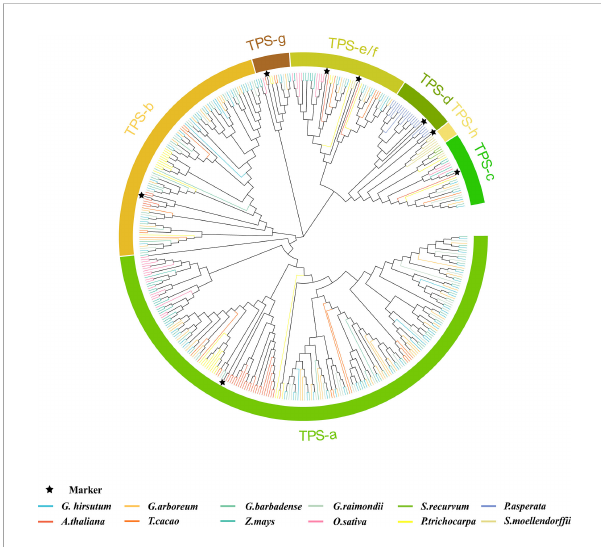
FIGURE 1 Phylogenetic analysis of the TPS gene family. MEGA7.0 was used to analyse the phylogenetic analysis of 430 sequences of 12 species: Gossypium hirsutum , G. arboreum , G. barbadense , G. raimondii , Zea mays , Picea asperata , Arabidopsis thaliana , Theobroma cacao , Oryza sativa , Populus trichocarpa , Sphagnum recurvum , and Selaginella moellendorf fi i . The TPS gene/protein in the published literature was used as control and labeled ★ . The colors of different branches of the phylogenetic tree represented different species, the same color represented the same species, and different colors in the outer circle represented different subfamily classi fi cations, which were divided into seven categories, namely TPS-a , TPS-b , TPS-c , TPS-d , TPS-e/f , TPS-g , and TPS-h